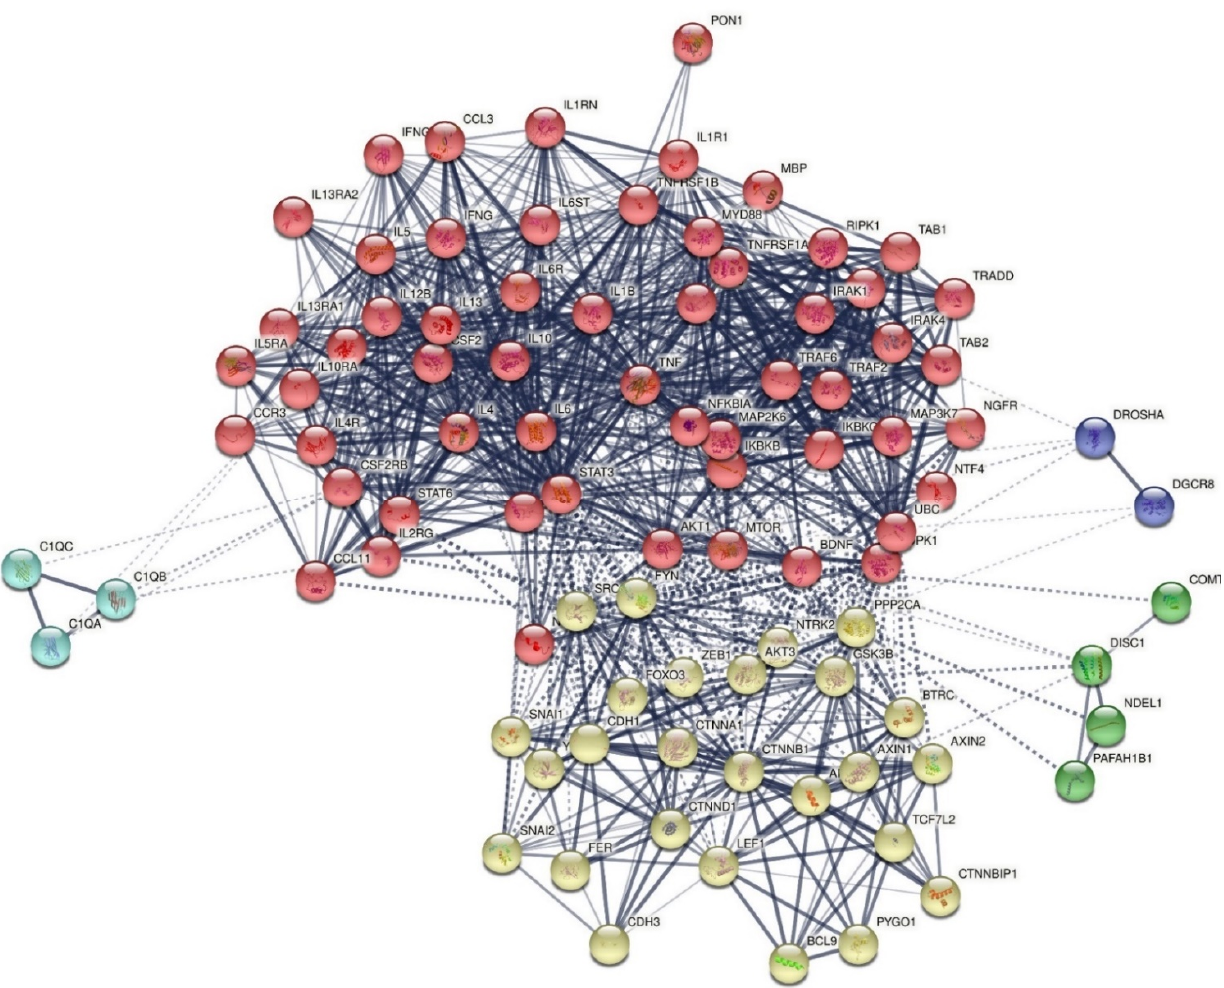
Figure 1. First order protein network showing 92 nodes and 1063 edges. MCL cluster analysis detected two clusters: (1) a first immune cluster (red color) was centered around BDNF, CCL11, CCL3, CSF2, IFNG, IL10, IL12A, IL13, IL1R1, IL4, IL5, IL6, MBP, PON1, and TNF, and (2) a second adhesion-associated cluster (yellow nodes) was centered around CDH1 and CTNNB1.